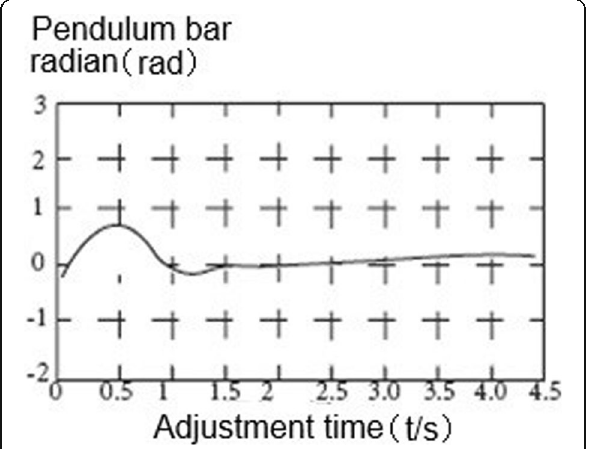
Fig. 5 The radian adjustment figure of the inverted pendulum by the method in this paper.